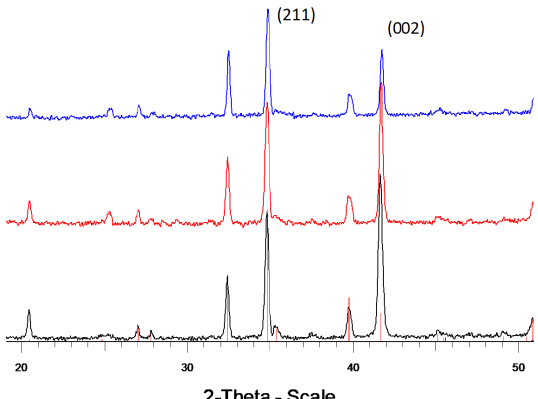
Figure 15. XRD patterns of samples of parent glass C4 heat treated at 850 °C for 5 h (black pattern), 900 °C for 1 h (red pattern) and 950 °C for 0.5 h (blue pattern).